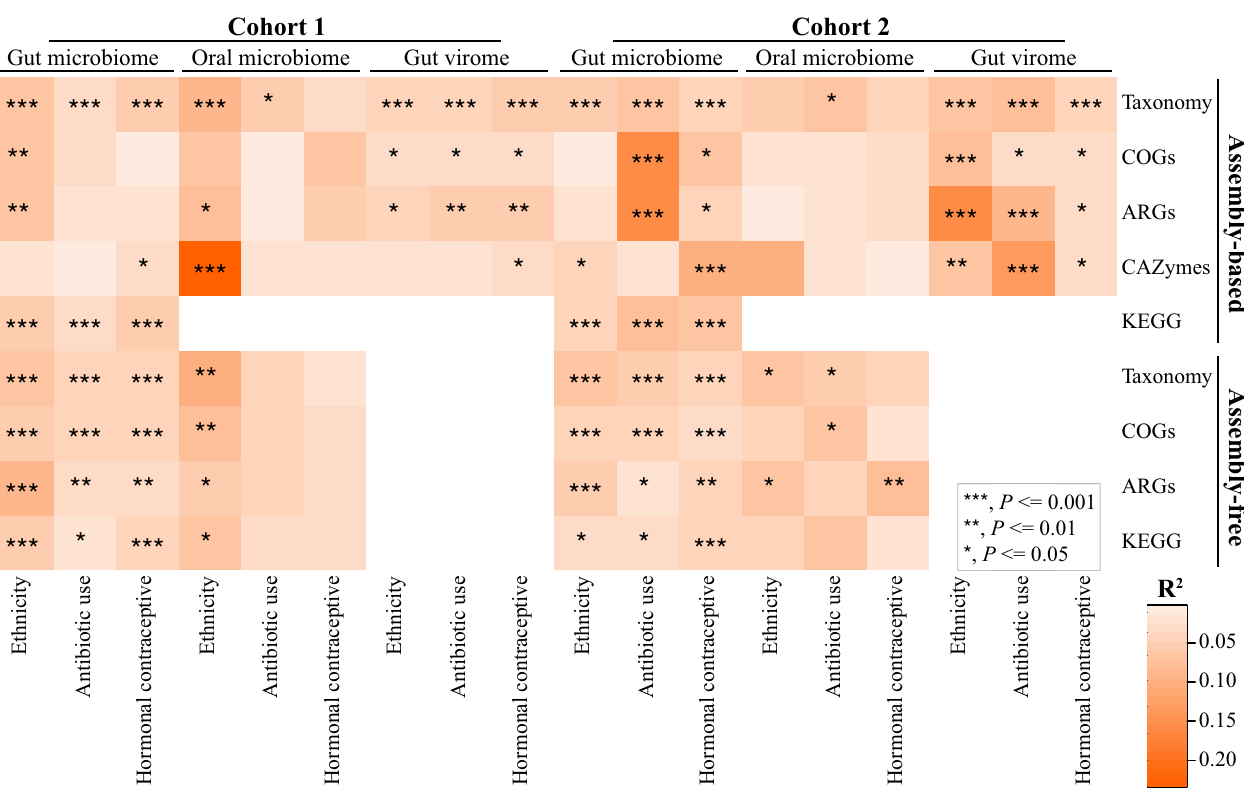
squares, Fig 3; cohort 2 gut: r 2 = 5.6%, P < 0.001, PERMANOVA with marginal sums of squares, Fig 3; cohort 2 saliva: r 2 = 5.4%, P < 0.001, PERMANOVA with marginal sums of